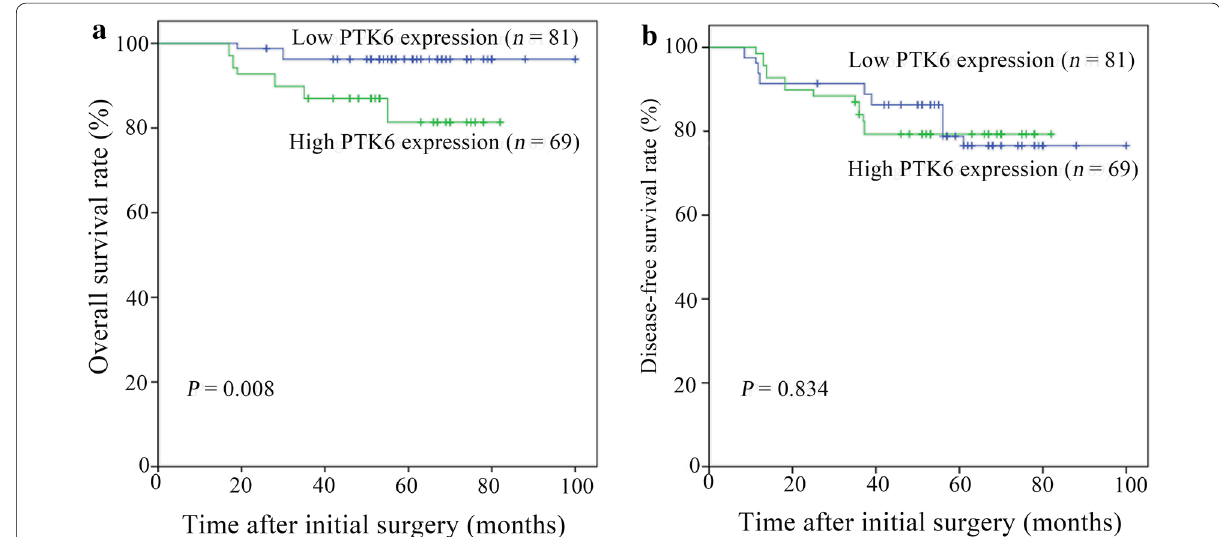
Fig. 3 Kaplan‑Meier survival curves for early‑stage cervical squamous cell cancer patients with low and high PTK6 expression. a high PTK6 expres‑ sion levels were associated with a short OS in patients with early‑stage cervical squamous cell cancer ( P between these two groups ( P 0.834) =